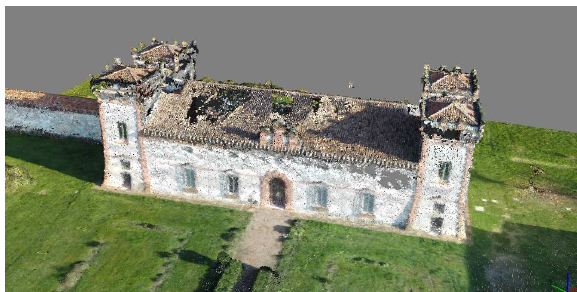
Figure 9: Point clouds obtained using precalibrated camera